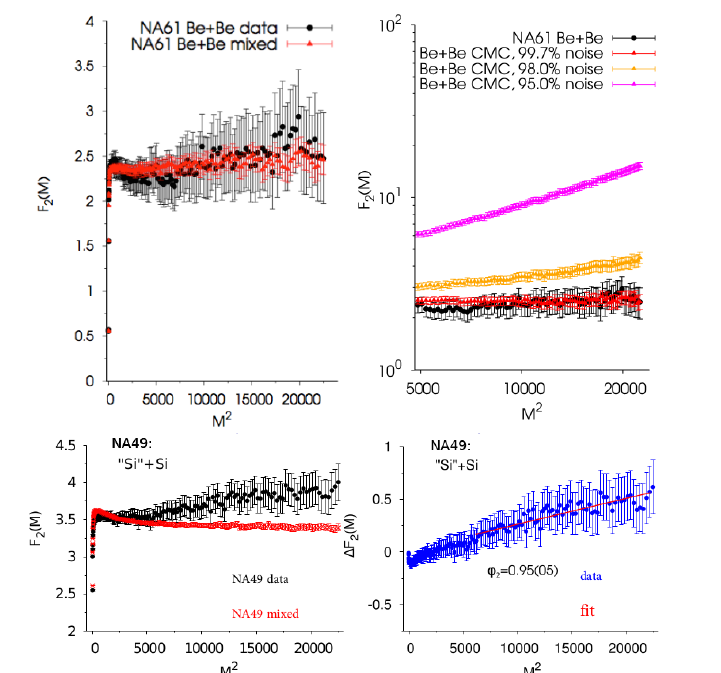
Figure 5. Top: Protons’ factorial moment dependence on the number of considered cells M in Be + Be at 150 A GeV / c (left) and predictions of CMC model for di ff erent fractions of critical component in the system (right) [14]. Bottom: Protons’ factorial moment dependence on the number of considered cells M in Si + Si at 158 A GeV / c (left) and predictions of CMC model for 5% critical component [15]. For details see